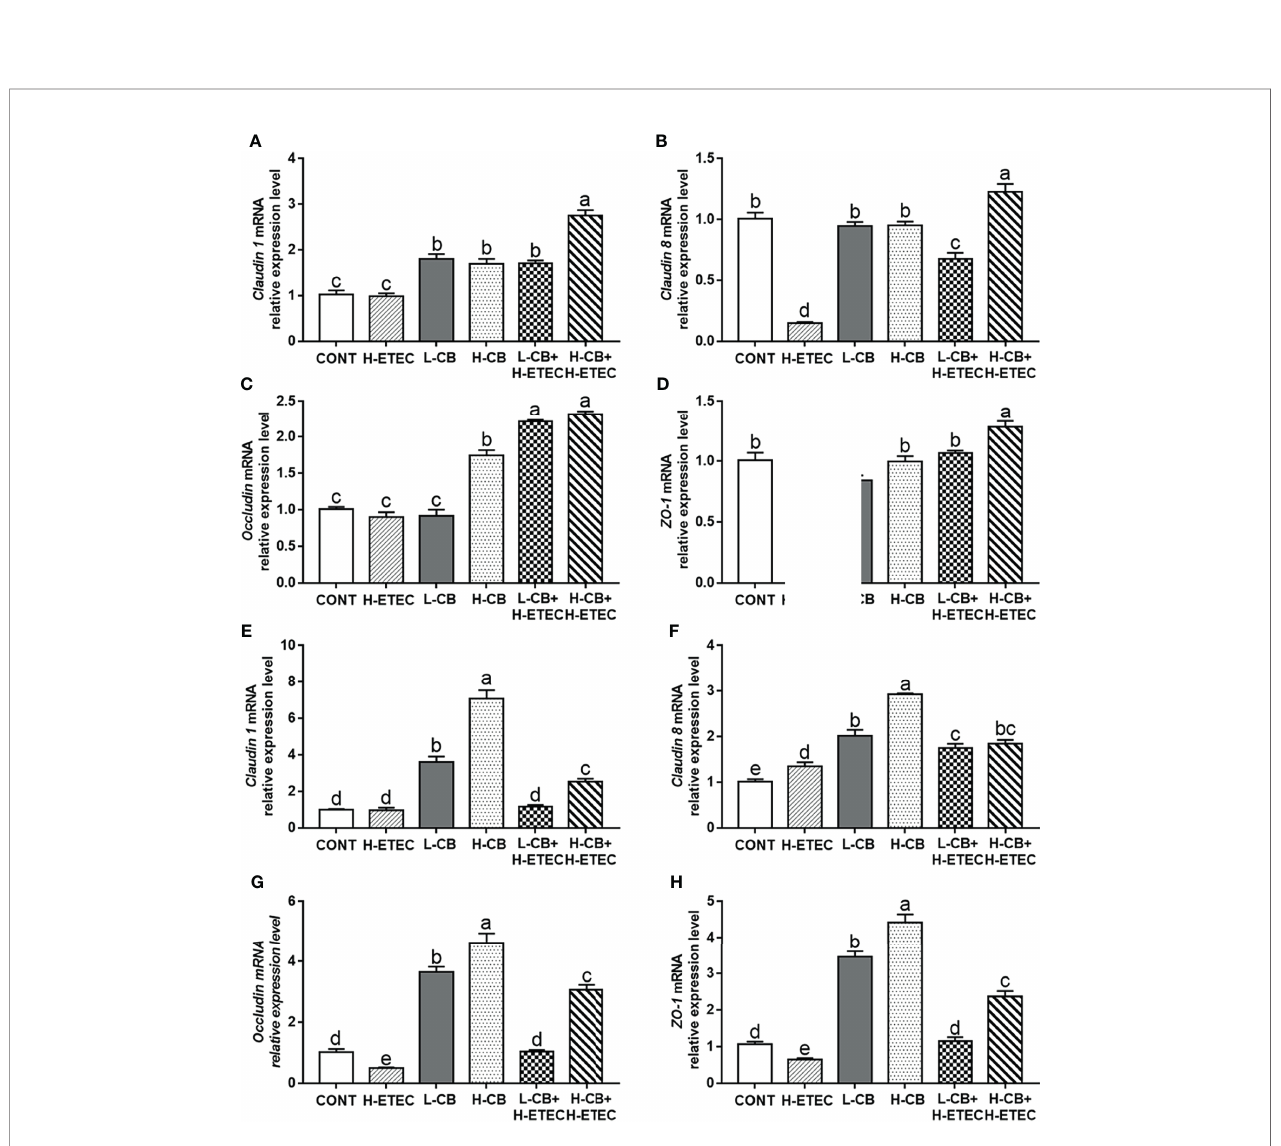
FIGURE 4 | Effects of CB and/or ETEC K88 on the mRNA expression levels of tight junction proteins. (A – D) The mRNA expression levels of claudin 1 , claudin 8 , occludin , and ZO-1 in the livers of mice were measured by qRT-PCR (n = 6 mice per group). (E – H) The expression of claudin 1 , claudin 8 , occludin , and ZO-1 in the jejunum of mice was measured by qRT-PCR (n = 6 mice per group). Data are shown as the ratios of abundance of target gene transcripts in treated mice to those in control mice after normalization to GAPDH . Values shown are the means ± SEM. Different small letters indicate signi fi cant differences ( p <